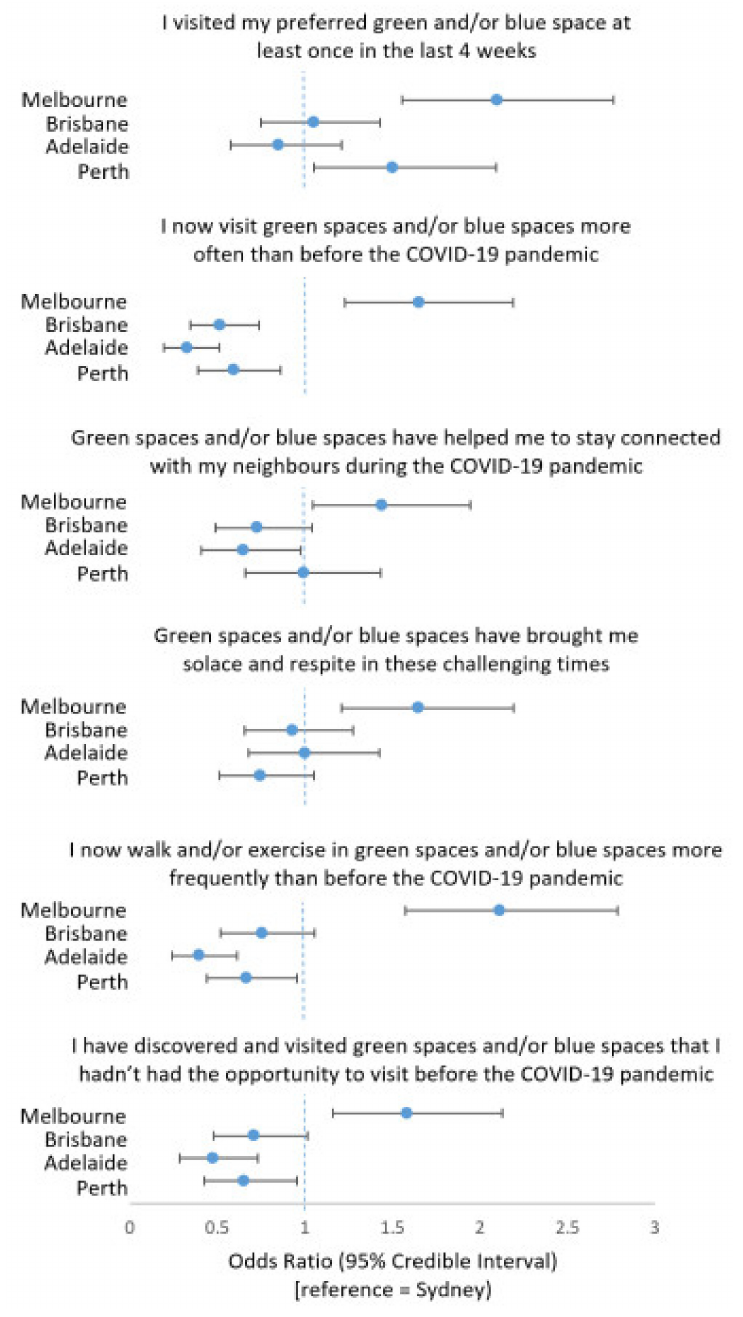
Figure 4. Differences between Australia’s most populous cities in visitation, changes in visits and felt benefits of preferred green or blue spaces during the COVID-19 pandemic (multilevel logistic